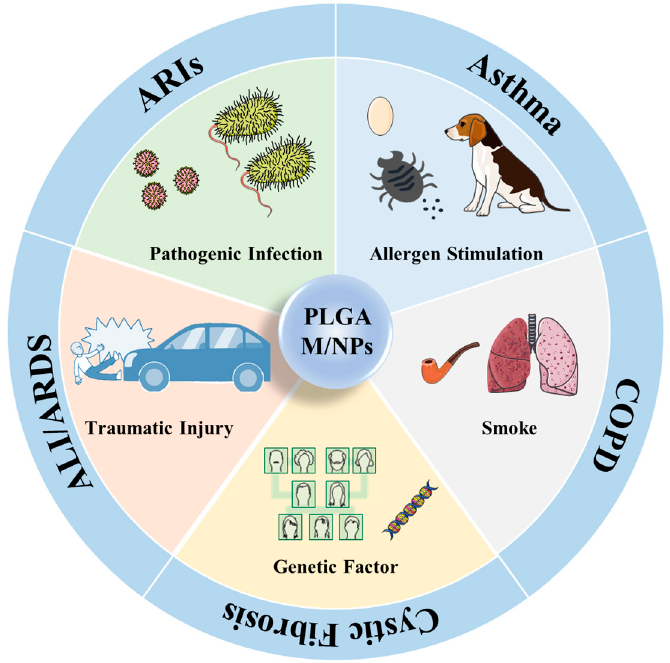
Figure 1. Application of PLGA M/NPs in different respiratory